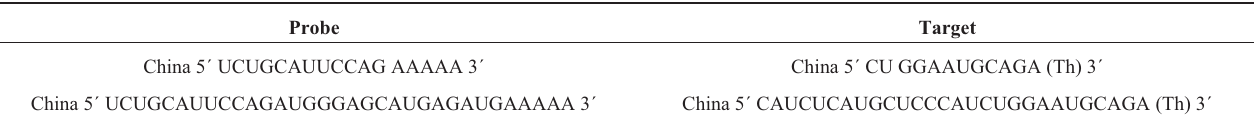
Table 2. Probes and target RNA oligonucleotides derived from influenza gene for